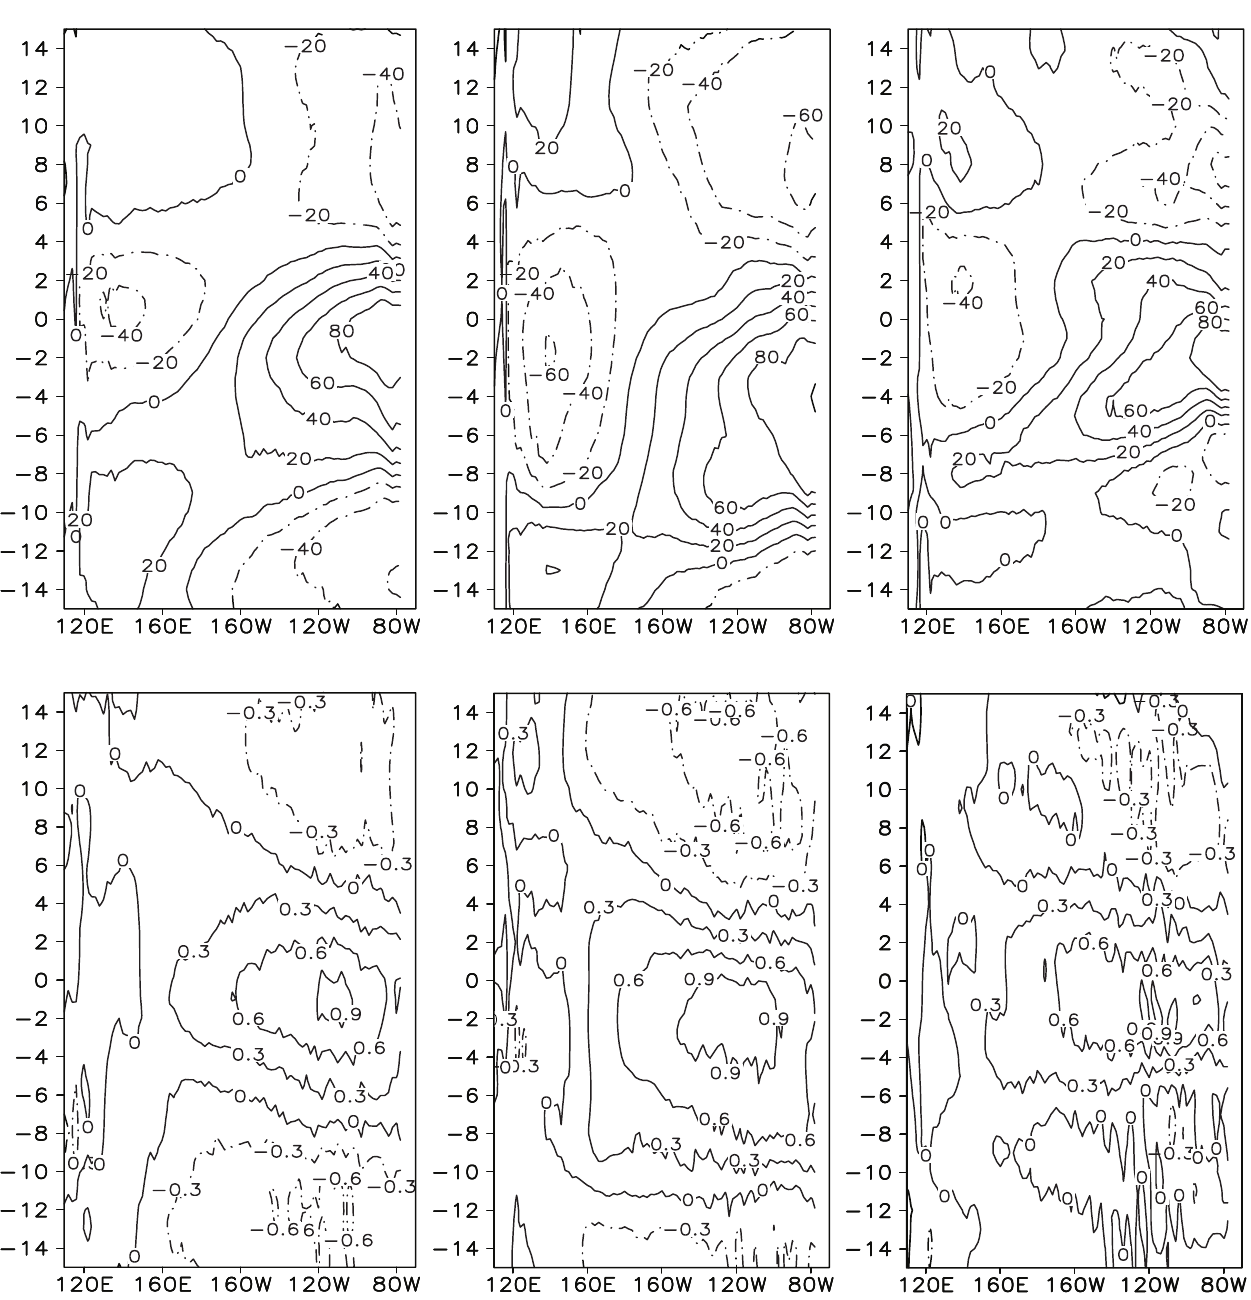
Fig. 2. Hoevmueller diagrams showing the evolution of ( top ) Heat Content (10 7 Jm − 2 ) and ( bottom ) SST ( ° C) anomalies averaged within the equatorial strip 3 ° S-3 ° N for warm events of type I (left), II (center) and III